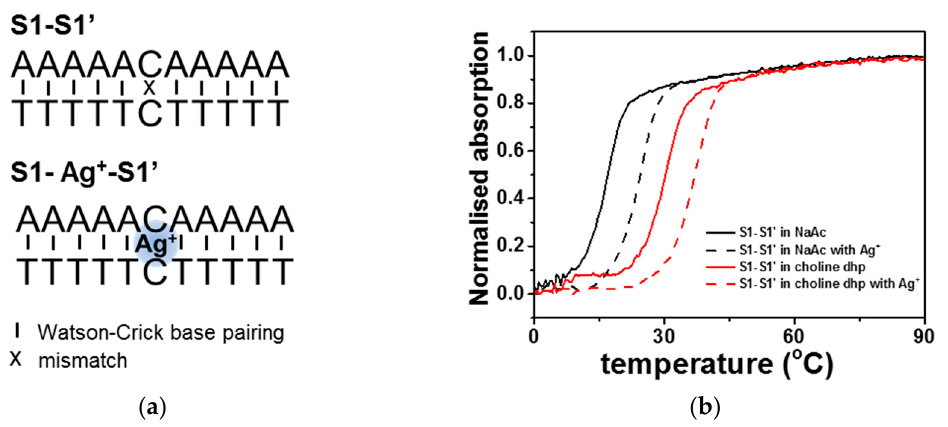
Figure 1. ( a ) The sequences used for the characterisation of stability and proposed base pairing in the absence and presence of Ag + ions. ( b ) The UV melting curves of 2 μ M S1-S1 ′ at 260 nm in the absence or presence of Ag + ions in a buffer consisting of 3.0 M sodium acetate-acetic acid (NaAc-HAc) (pH 7.0) or 3.0 M choline dihydrogen phosphate (dhp)-NaOH (pH 7.0). or 3.0 M choline dihydrogen phosphate (dhp)-NaOH (pH